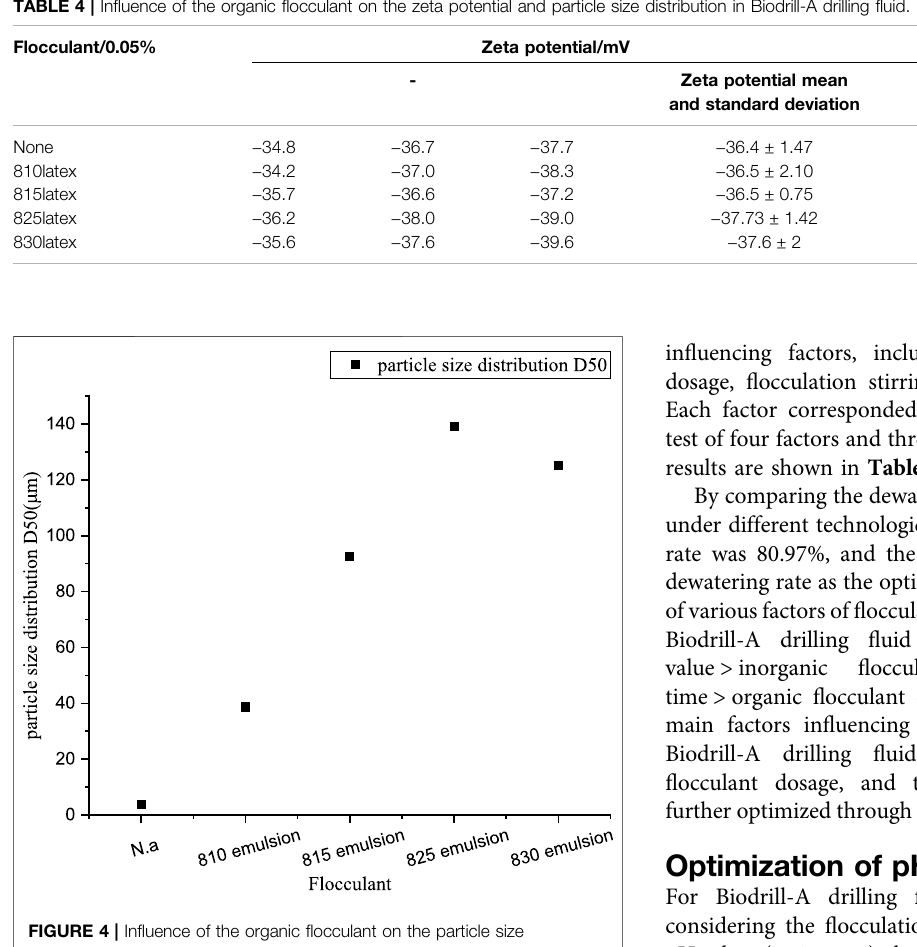
Frontiers in Energy Research |